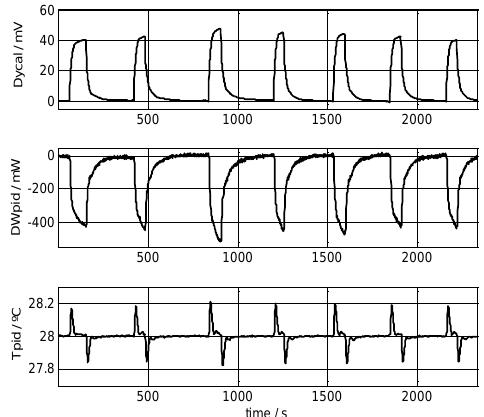
Figure 11. Consecutive measurements made on the left wrist of a healthy, 58-year-old male subject. Calculated mean powers: 147, 162, 173, 177, 167, 162 and 150 mW (162 ± 15 mW), at T room = 21 °C, T pid = 28 °C. The baselines of the curves for the calorimetric signal and the thermostat’s power were corrected. Thermostat temperature is also shown ( T pid ). V Peltier = 0.2 V.